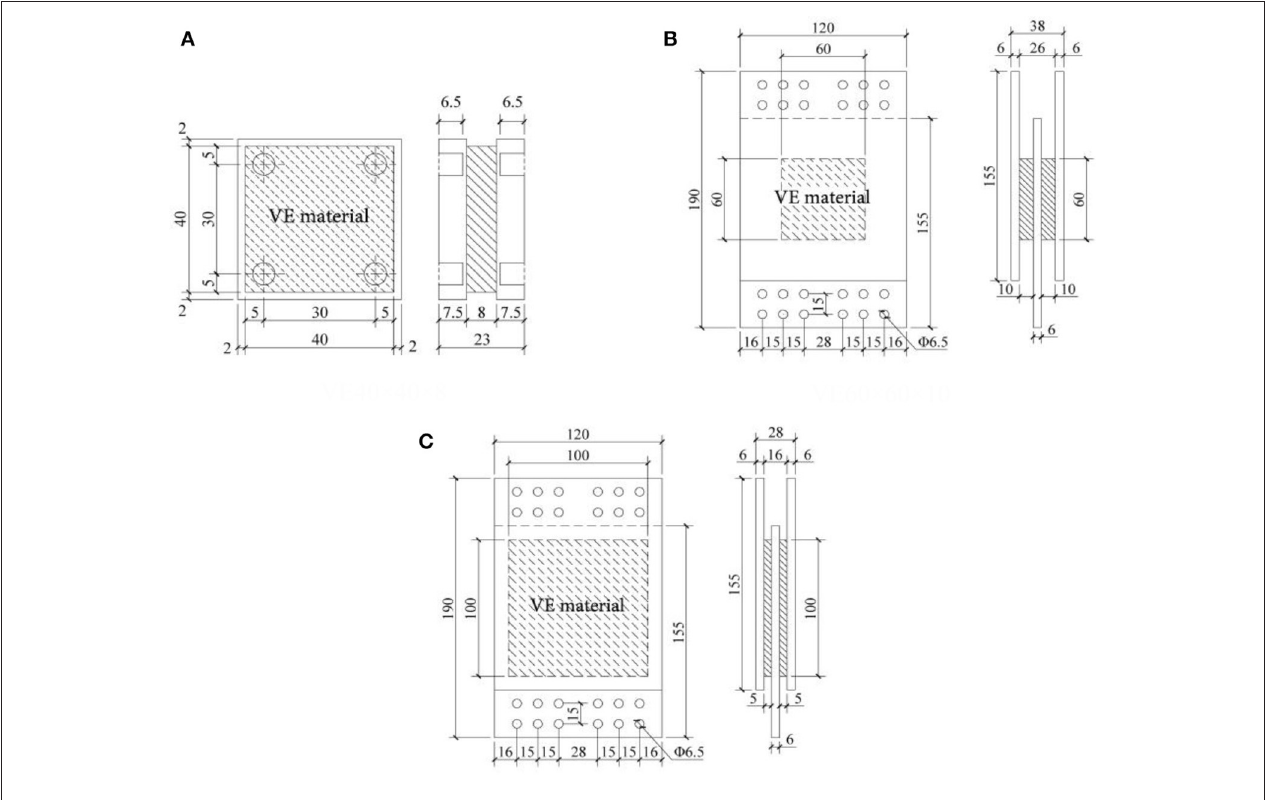
FIGURE 1 | Diagram of the different type of test specimens of (A) type “VE40 × 40 × 8,” (B) type “VE60 × 60 × 10” and (C) type “VE100 × 100 ×